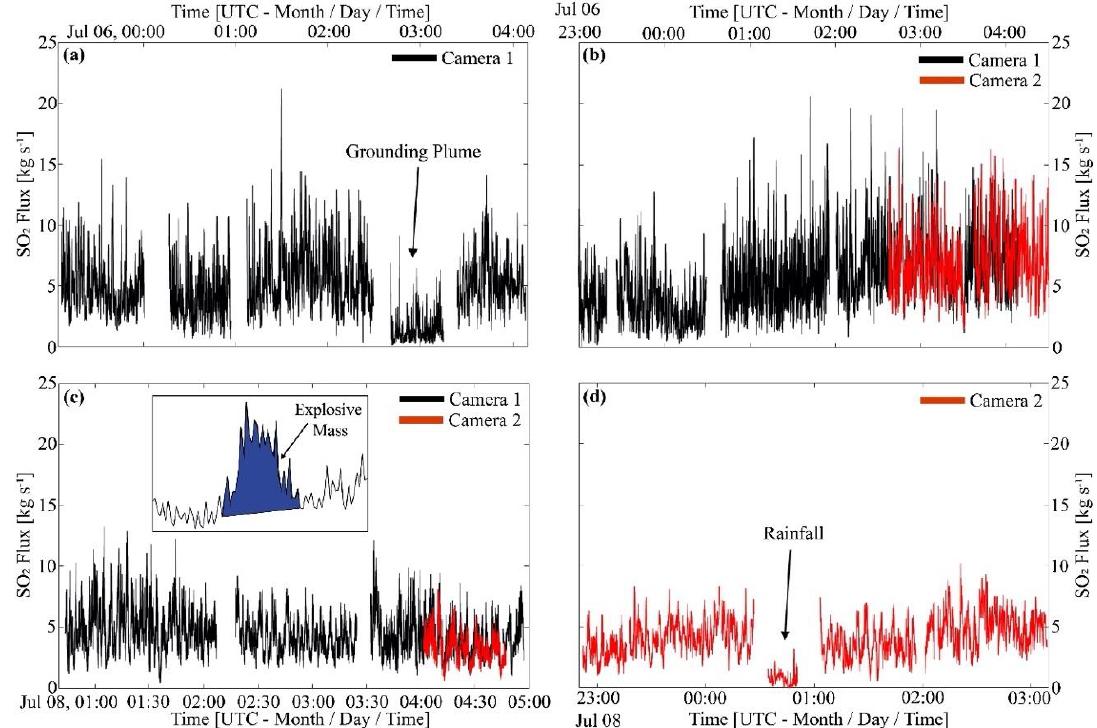
Figure 6. ( a – d ) Retrieved gas fluxes, where clear peaks correspond to Strombolian explosions, for all the image data captured during the observation period; also highlighted are periods where the plume was grounded ( a ) and heavy rainfall was encountered ( d ). ( c ) An example of the explosive mass determination, where integration occurs below the explosion peak (e.g., shaded blue area), above the background levels.